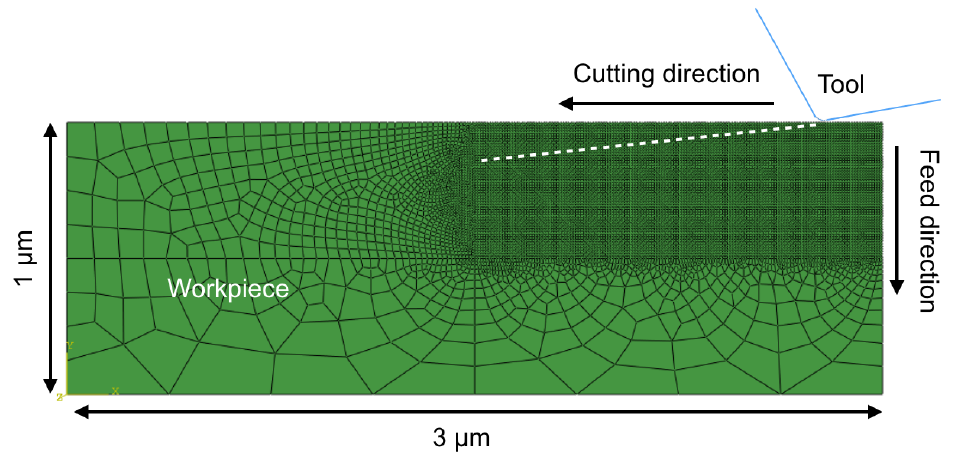
Figure 6. Schematic diagram of the workpiece and the cutting tool for the grooving simulations. The white dashed line shows the trajectory of the tool tip during grooving. The initial contact occurs on the flat surface at some distance to the corner of the model. The workpiece has a dimension of 3 × 1 µ m, and the cutting tools was chosen to be rigid with a negative rake angle. A denser mesh was used around the grooving region, while in remote regions a coarser mesh was